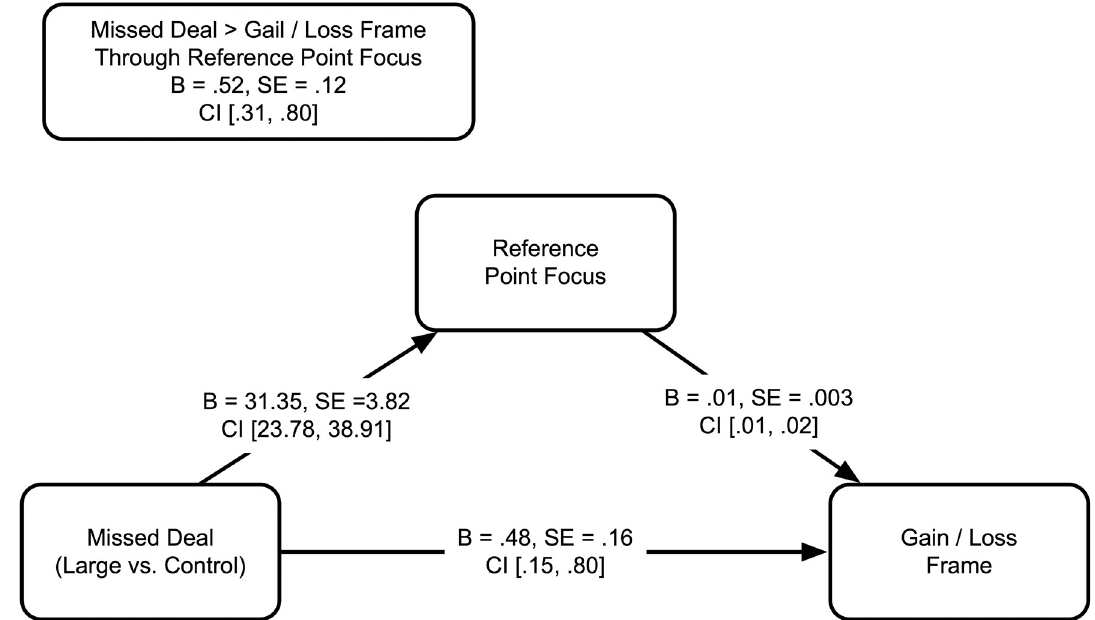
Fig 2. Indirect effect of missed deal on gain / loss frame through reference point